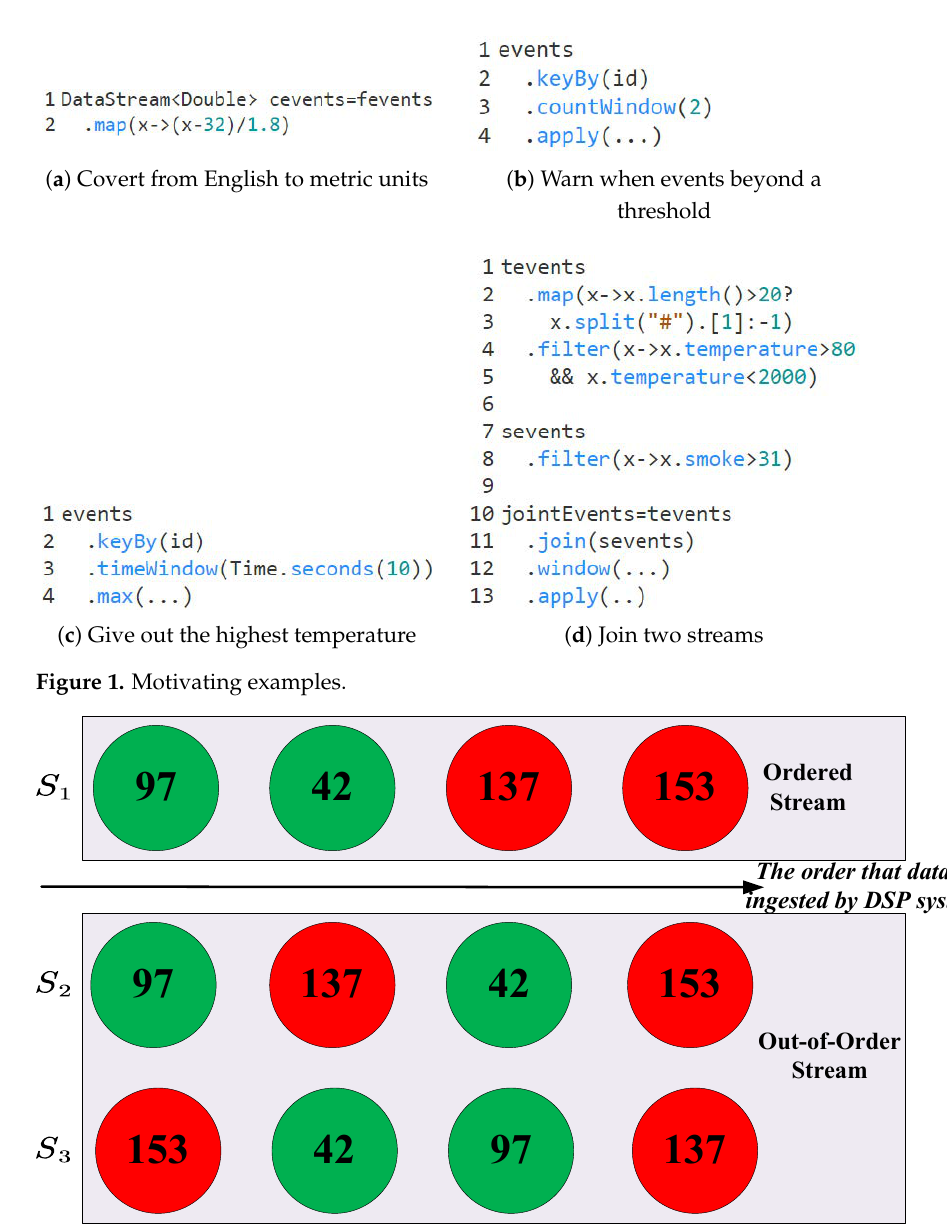
Figure 2. Three streams with the same data but in a different